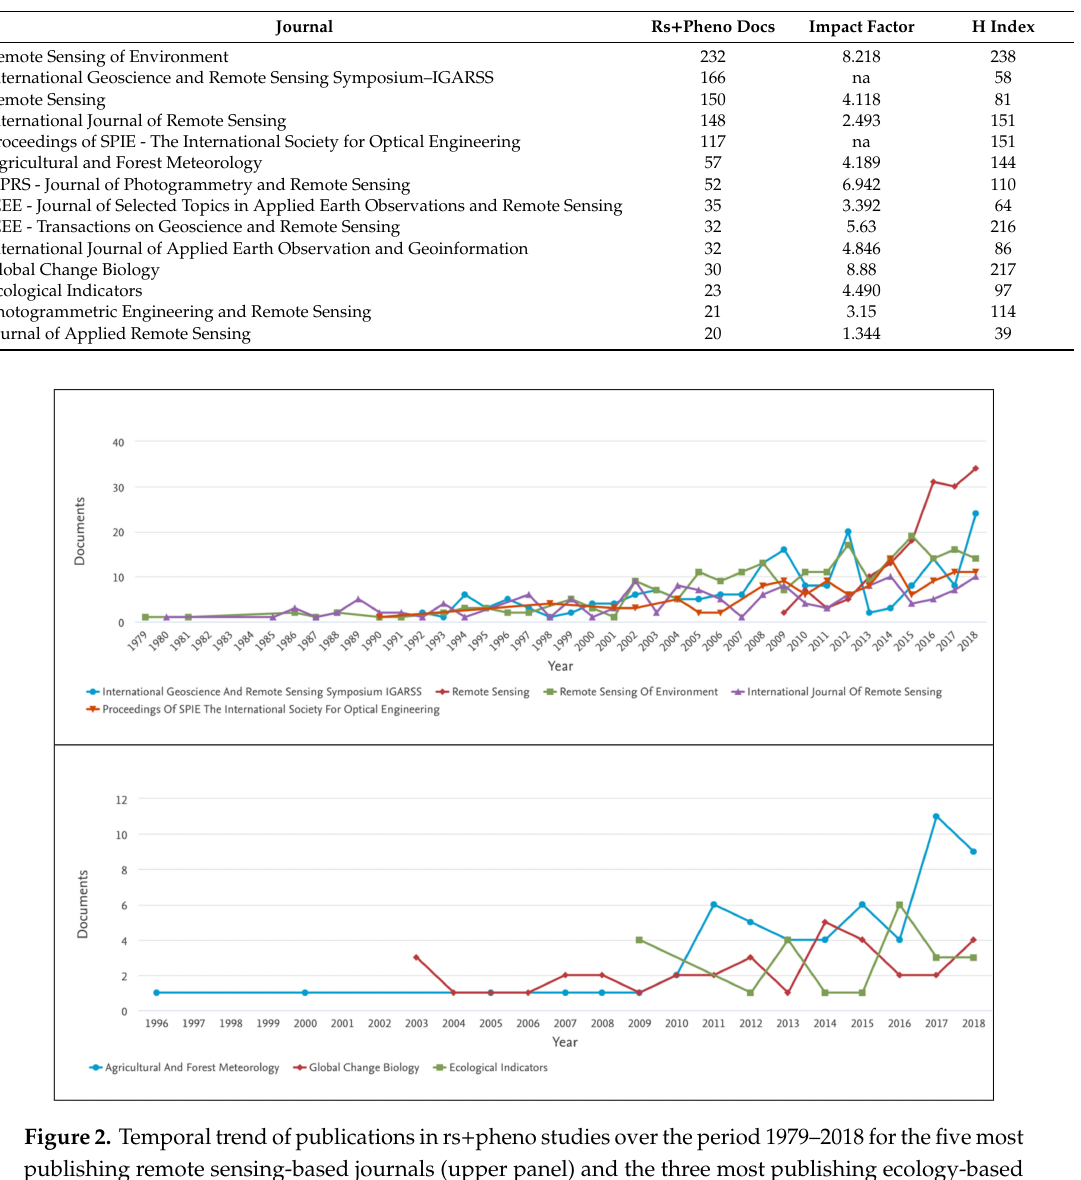
Table 1. List of the most used scientific journals in rs + pheno (remotely sensed phenology) studies ( > 20 documents in 1979–2018), with corresponding impact factor (source: Thomson Reuters) and H index (source: SCImago Journal Rank - SJR).